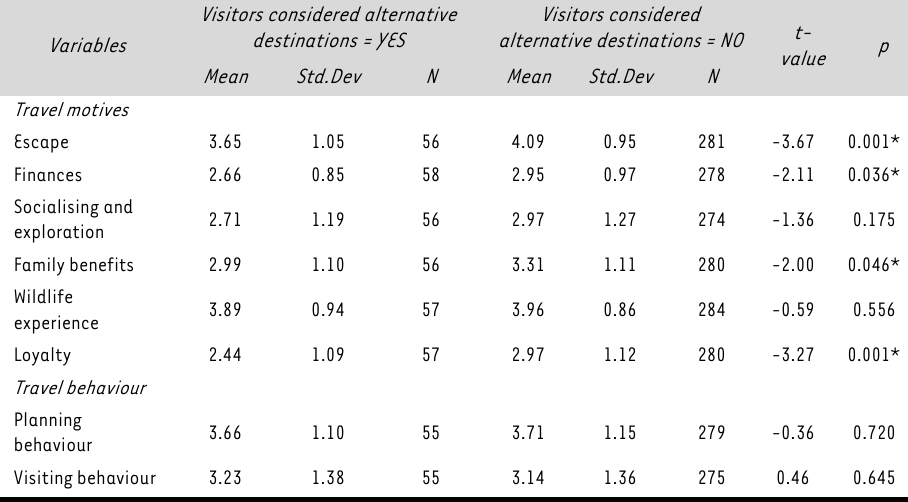
TABLE 5: t-test results of differences between visitors who considered an alternative destination and those who did not based on travel motivations and travel